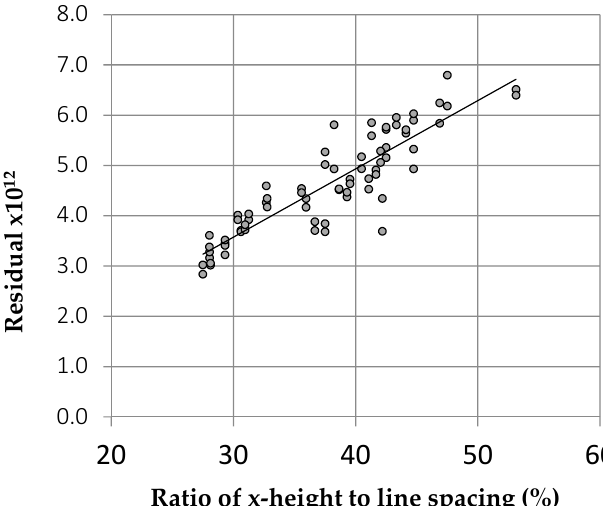
Figure 10. Relationship between the output of the algorithm (residuals) [25] and the ratio of x-height to line spacing for 72 texts, with various fonts, font size and spacing, with and without justification. The font with one of the lowest residuals, Open Sans, had a ratio of x-height to line spacing of 43%, which was large, relative to other fonts. Note that iBooks currently permit the selection of font but not the ratio of x-height to line spacing, except in so far as line spacing co-varies with font. The di ff erences in the iBook selections were not therefore attributable to line spacing but to other aspects of the typefaces that the algorithm was also successful at capturing.